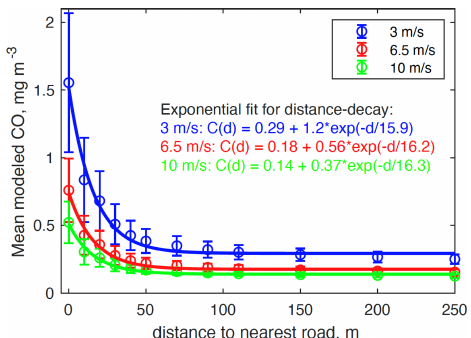
Figure 13. Relationship between the modeled ground-level CO concentrations and the distance to the nearest major roads (assum- ing an east wind with emissions during rush hours). The circles and error bars are means and standard deviations,